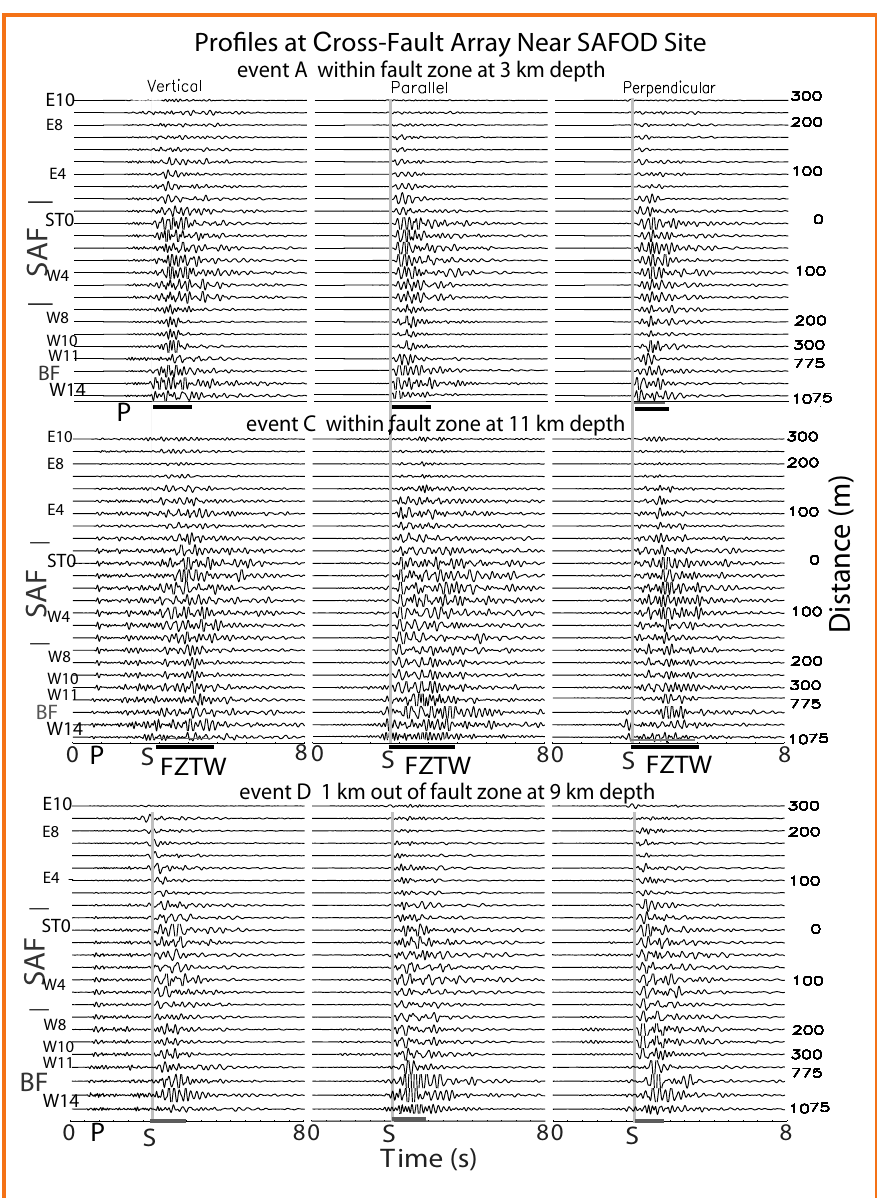
Figure 2. Three-component seismograms at the cross-fault array for three microearthquakes occurring near the SAFOD site. Seismograms have been <6-Hz filtered and plotted in a fixed amplitude scale in each plot. Prominent fault-zone trapped waves (FZTWs) with large amplitudes and long wavetrains after S-arrivals from the on-fault events A and C arrive at stations between E6 and W4 in a ~200-m range across the SAF. Vertical lines are aligned with S arrivals. Horizontal bars denote wavetrain lengths of FZTWs after S-arrivals. The FZTW wavetrains from event C occurring at ~11 km is ~2.2 s long, but is ~1.2 s for event A at ~3 km. The wavetrain for the off-fault event D occurring at the similar depth of event C is much shorter, indicating that the low-velocity waveguide on the SAF likely extends down to the depth at least 3 km. Some seismic energy is trapped within the branch fault